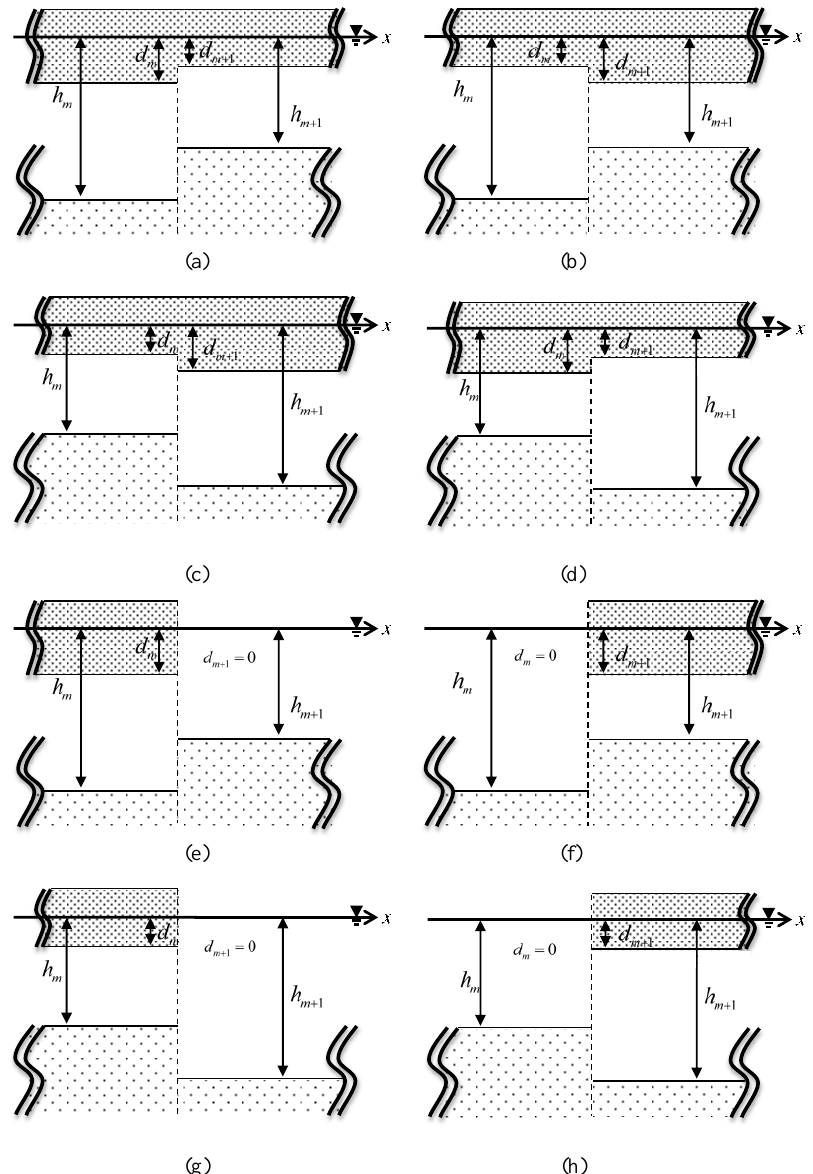
Figure 2. Schematics for eight different situations of shelves separated by abrupt connections.